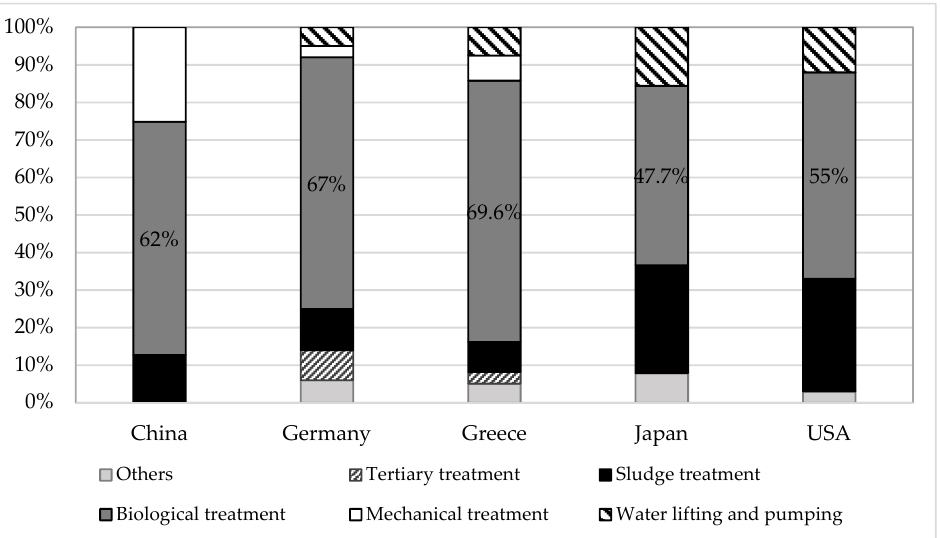
Figure 1. Typical Energy End-Uses in Municipal WWTPs, as percentage of the total in different countries (elaborated with data from [9–13]).